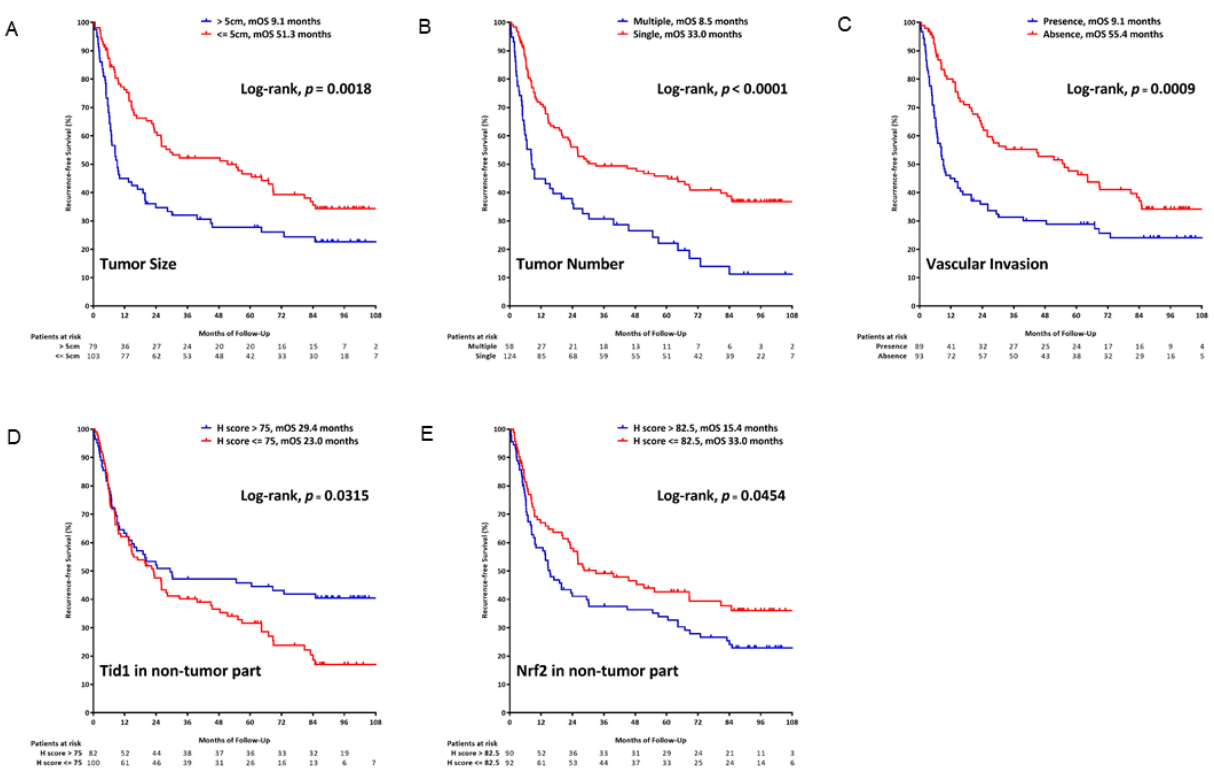
Figure 3. Recurrence-free survival (RFS) of the HCC patients categorized by ( A ) tumor size of 5 cm; ( B ) single or multiple tumors; ( C ) presence of microvascular invasion or not; ( D ) Tid 1 expression level in the non-tumor part; and ( E ) Nrf2 expression level in the non-tumor part. The Kaplan–Meier method with log-rank test was used for RFS analyses.